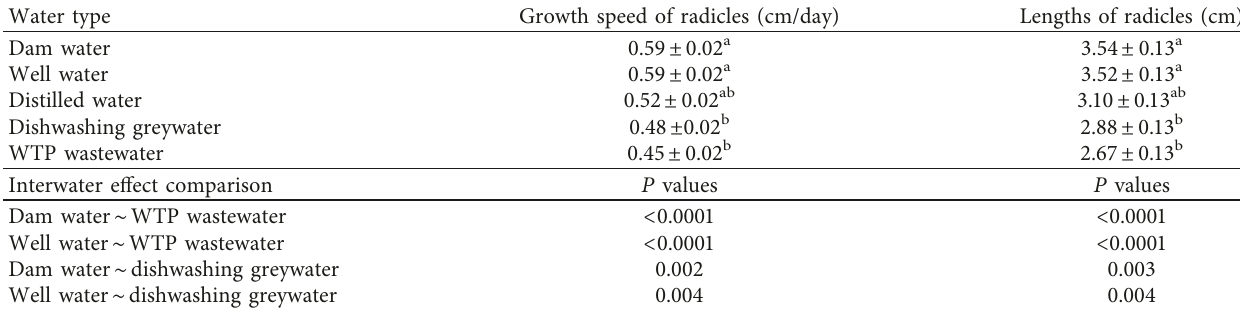
Table 7: Effect of watering water on growth speed and final length of